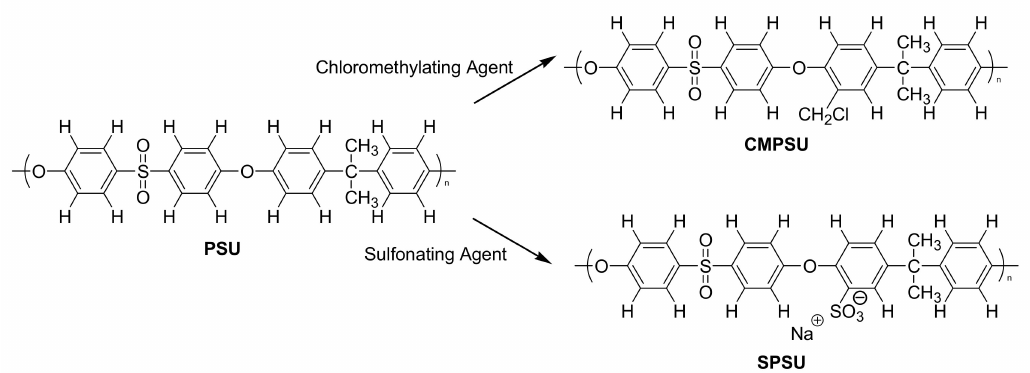
Figure 1. Synthesis of chloromethylated polysulfone (CMPSU) and sulfonated polysulfone